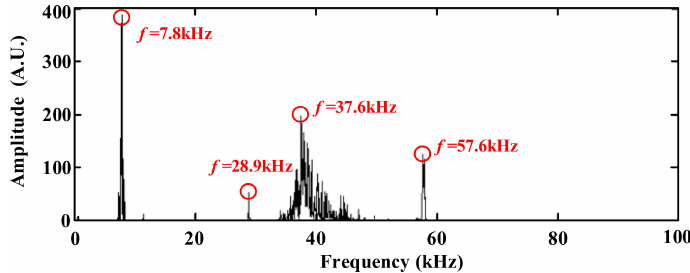
Figure 12. Characteristic frequency distribution diagram using